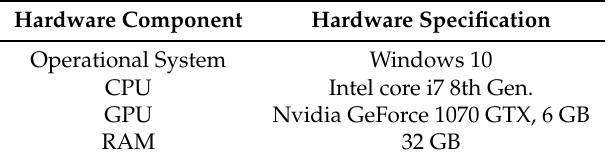
Figure 6. ( A ) A synthetic forest image; ( B ) The same image with the delineation of each example tree crown. Table 3. Hardware configuration applied for Mask R-CNN training and